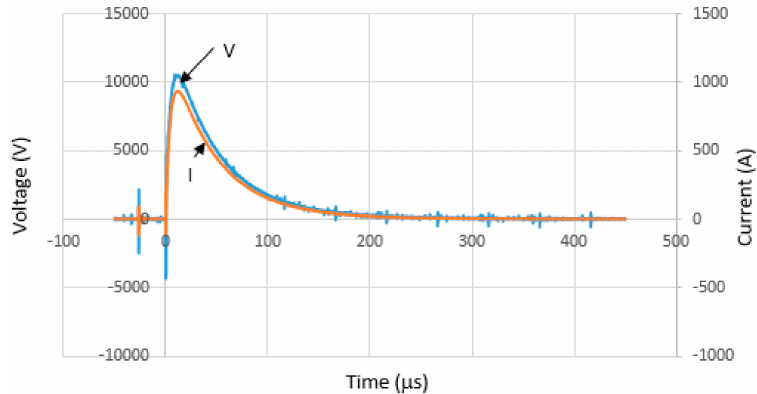
Figure 6. Voltage and current traces of positive polarity for electrodes installed at site 2 at a charging voltage of 30 kV.